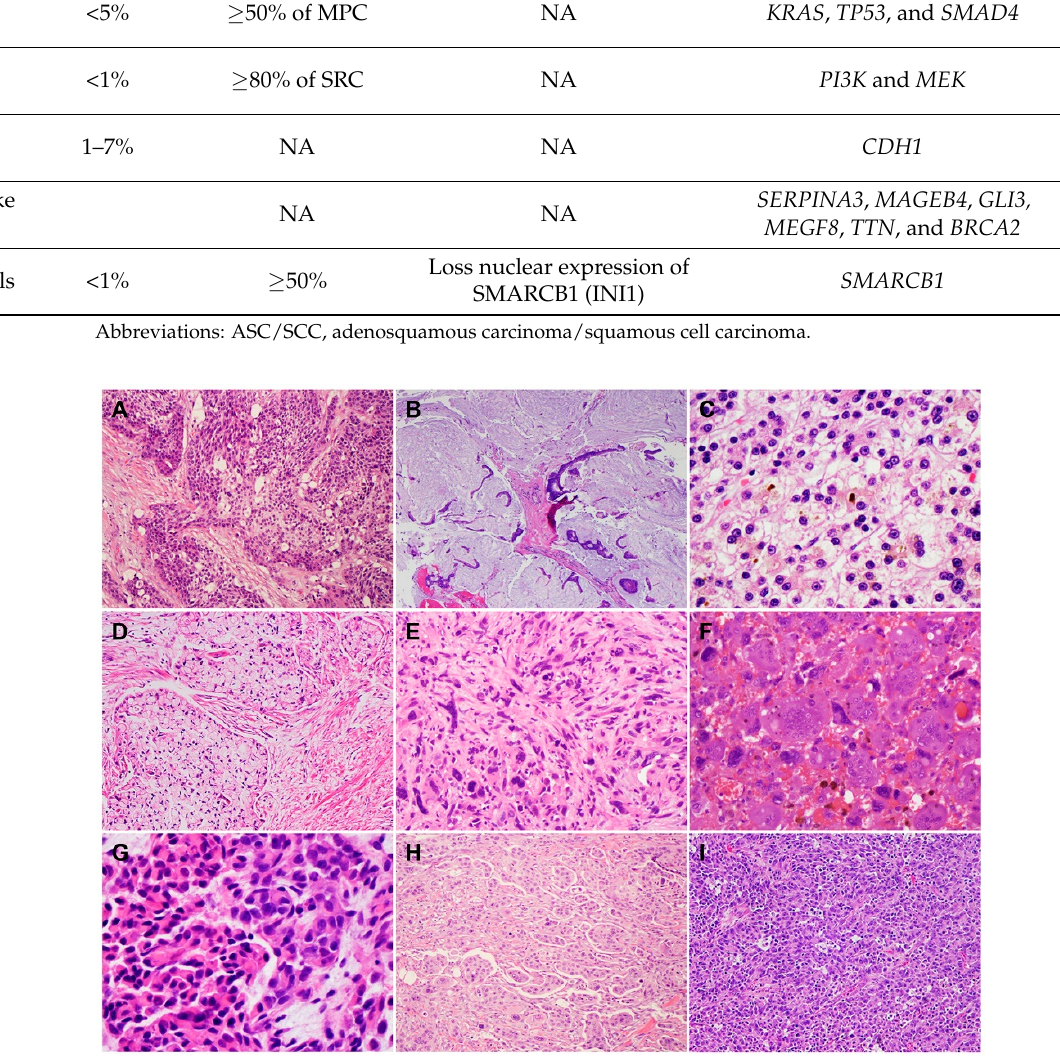
Figure 3. Histological subtypes of pancreatic ductal adenocarcinoma (hematoxylin and eosin stain): ( A ) Adenosquamous carcinoma; ( B ) colloid carcinoma; ( C ) hepatoid carcinoma with bile lakes; ( D ) signet-ring cell carcinoma; ( E ) undifferentiated carcinoma; ( F ) undifferentiated carcinoma with osteoclast-like giant cells; ( G ) undifferentiated carcinoma with rhabdoid cells (rhabdoid carcinoma); ( H ) micropapillary carcinoma; ( I ) medullary carcinoma. Table 1. The subtypes of pancreatic ductal adenocarcinoma and their associated molecular altera- tions.